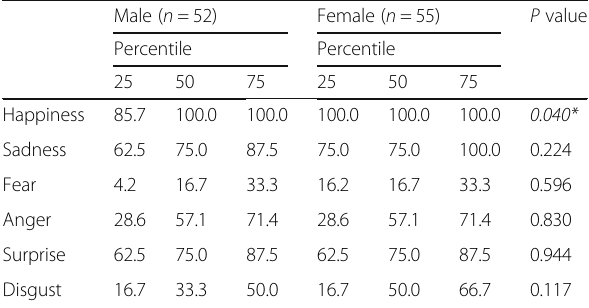
Table 3 Comparison of facial expression recognition test accuracy by gender Male ( n = 52) Female ( n =